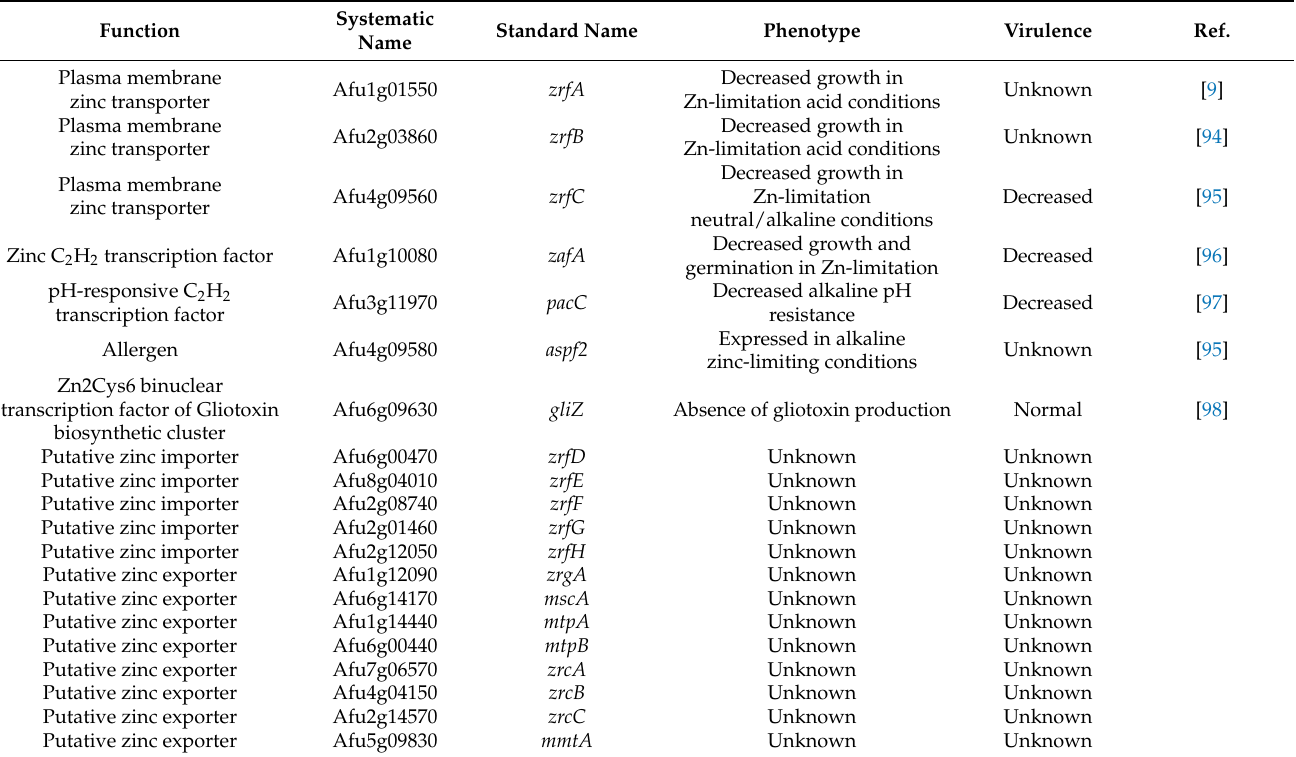
Table 3. A. fumigatus genes implicated in zinc metabolism and their implication for fungal phenotype and virulence.